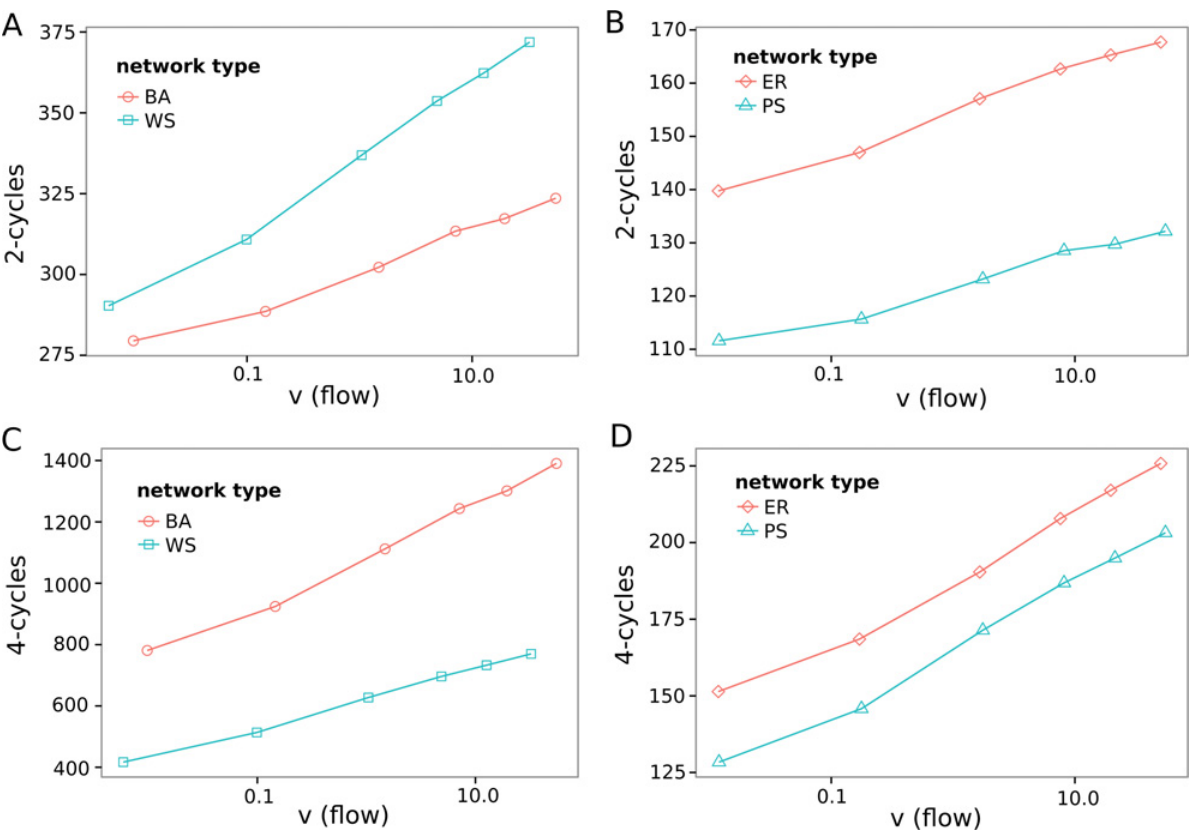
Fig 5. Number of 2- and 4-cycles in the (directed) substrate graphs of the nonlinear reaction networks. The plots show the number of additional cycles depending on the flow through the network in comparison to the same network with random reaction directions (Table 1). Each data point is the average of all simulations with boundary points distance of 3 and fixed boundary concentrations ( c 1 = 0.1 c 2 = 0.2 ... 60).